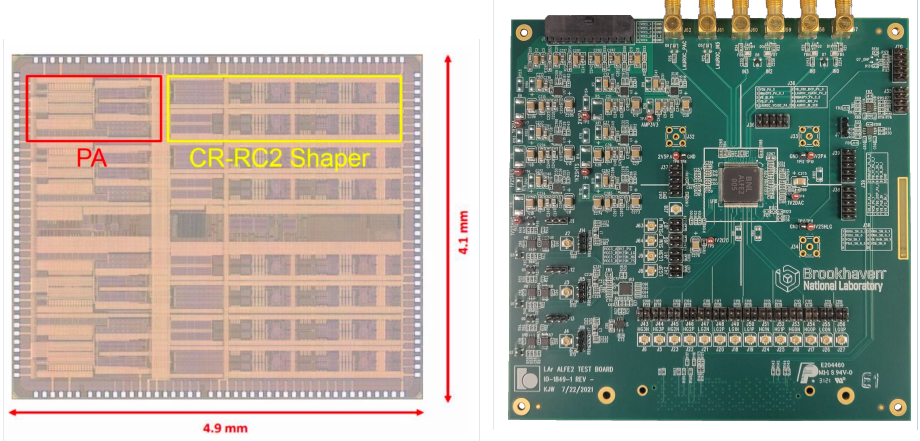
Figure 3. Die image of the PA/S ALFE2 pre-prototype ASIC with key circuit elements outlined ( left ), and the corresponding ALFE2 testboard with soldered chip ( right